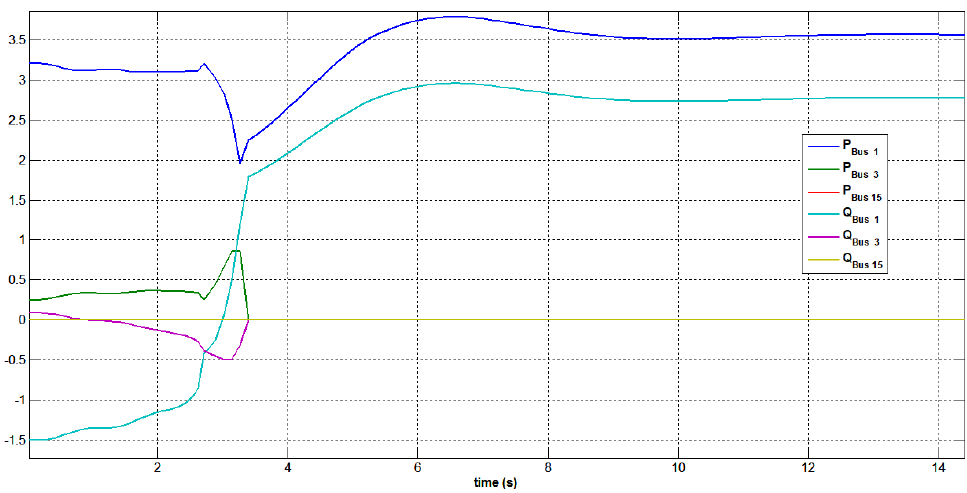
Figure 31. Rotor speed response of swing bus 1 and at PV bus 3 after disconnection of SPVGP.